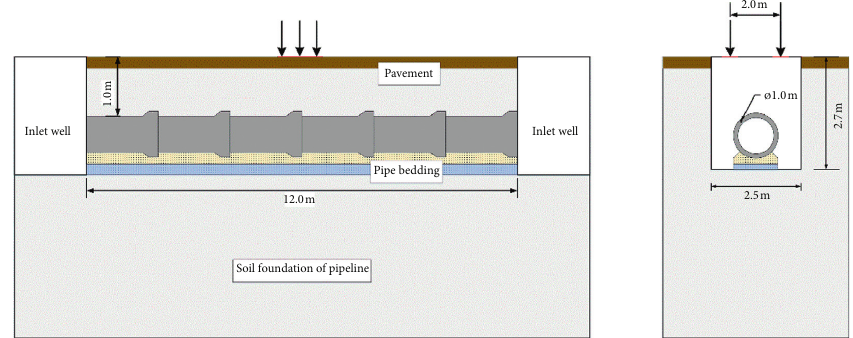
Figure 30: Full-scale test of multiphysics coupling of the concrete pipeline.